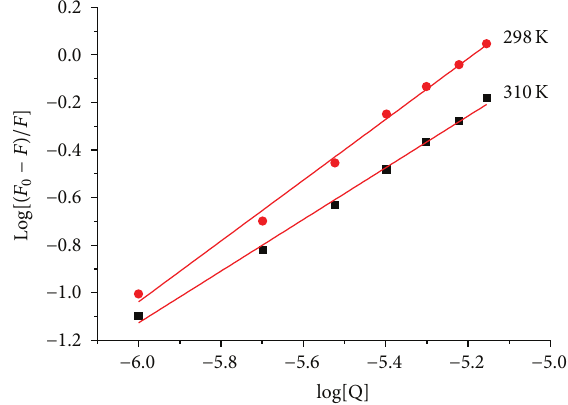
= 𝐶 = 1 × 10 −6 M; HSA Hyp